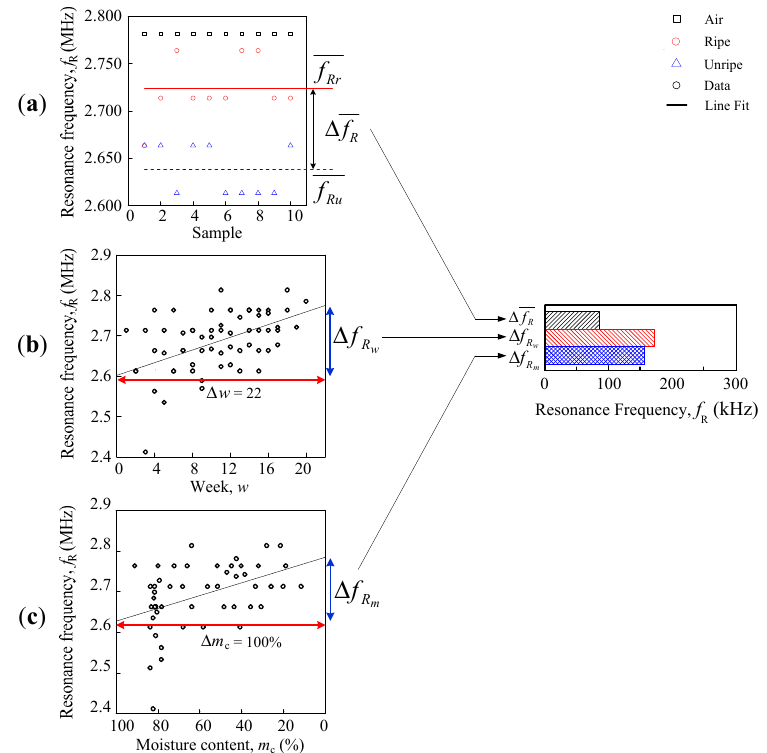
Figure 6. Resonance frequency for ( a ) direct ripe-unripe comparison, ( b ) resonance frequency against the weeks and ( c ) resonance frequency against moisture comparison for selected flat-type air coil peak.